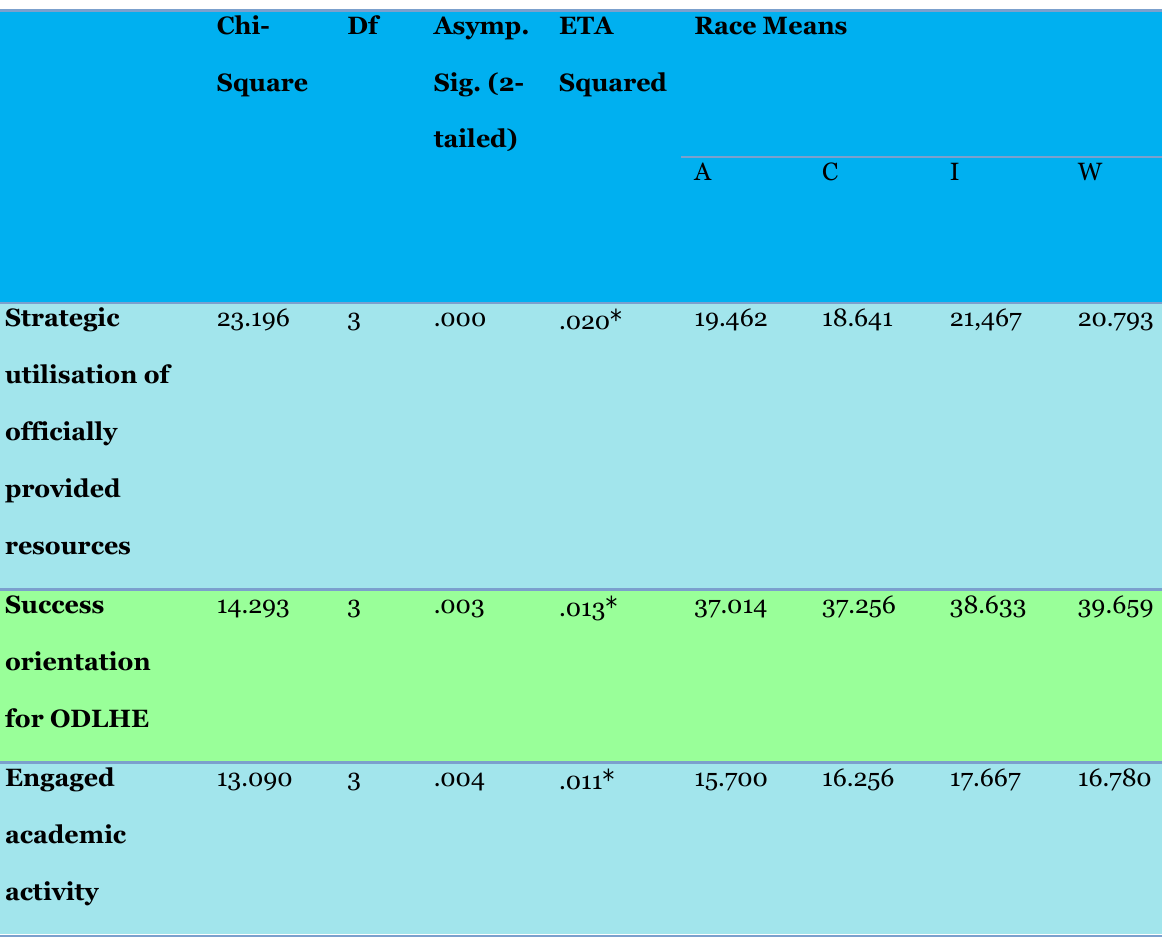
Chi- Df Asymp. ETA Square Sig. (2- tailed)